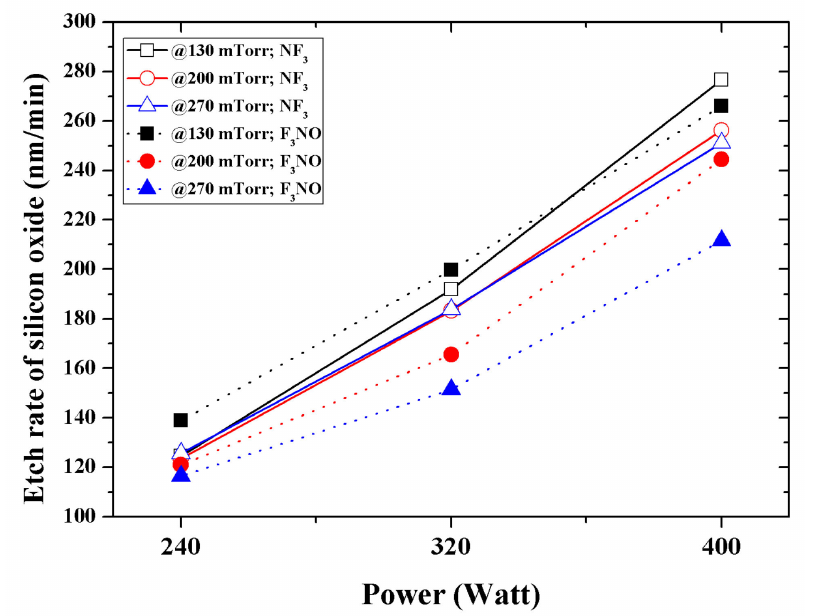
Figure 7. Etch rate as a function of input for various working pressures during plasma silicon oxide etching at a total flow rate of 120